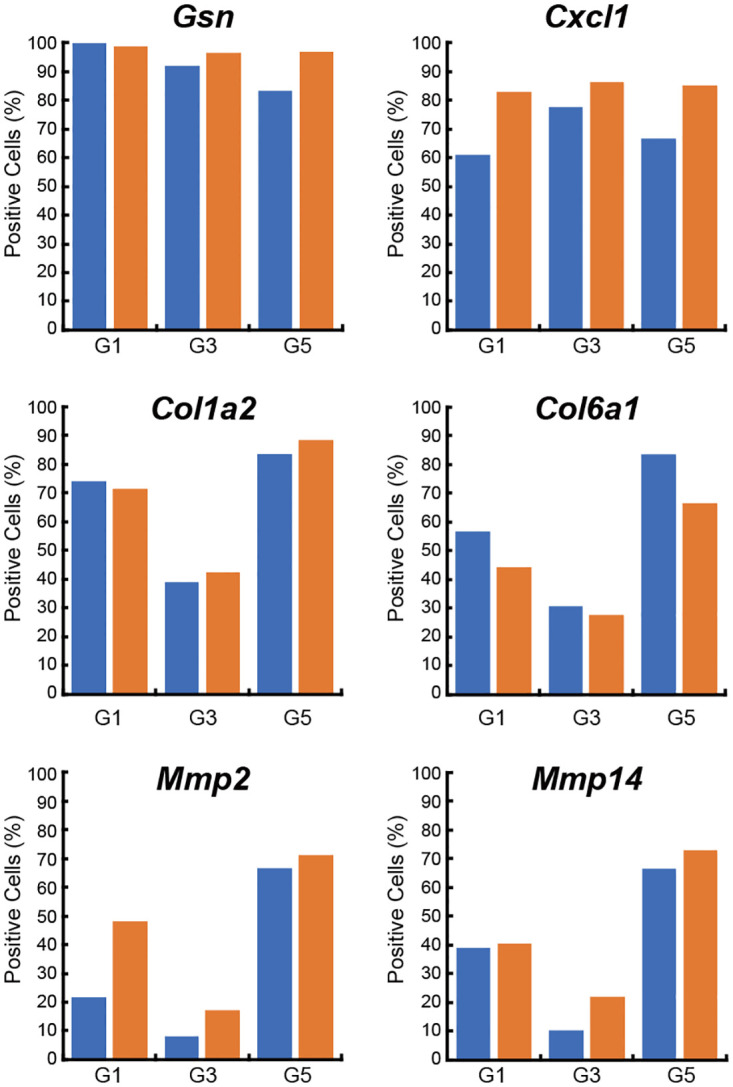
Age-associated changes in ASCs expressing ASC marker genes.The percentages of cells positive for the expression of Gsn, Cxcl1, Col1a2, Col6a1, Mmp2, and Mmp14 in Groups 1, 3, and 5 from young (blue) and old (orange) mice are shown. G1: Group 1 (cell number, n = 191), G3: Group 3 (cell number, n = 136), G5: Group 5 (cell number, n = 134).